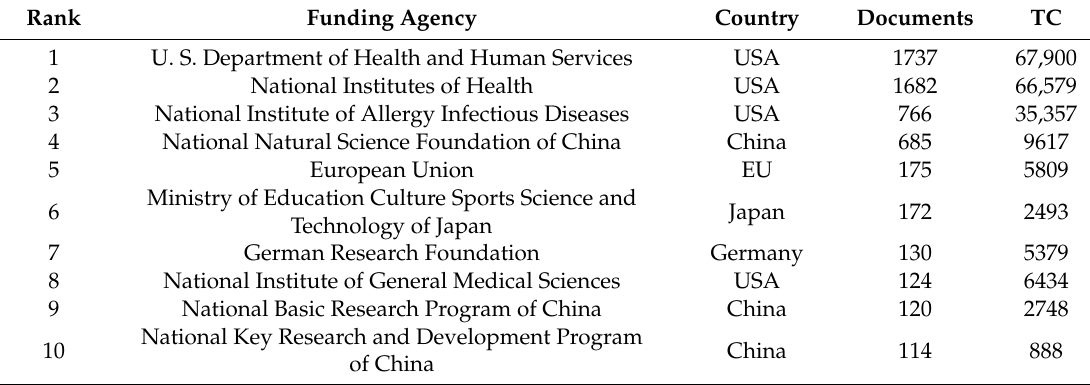
Table 4. Top 10 funding agencies with highest output.